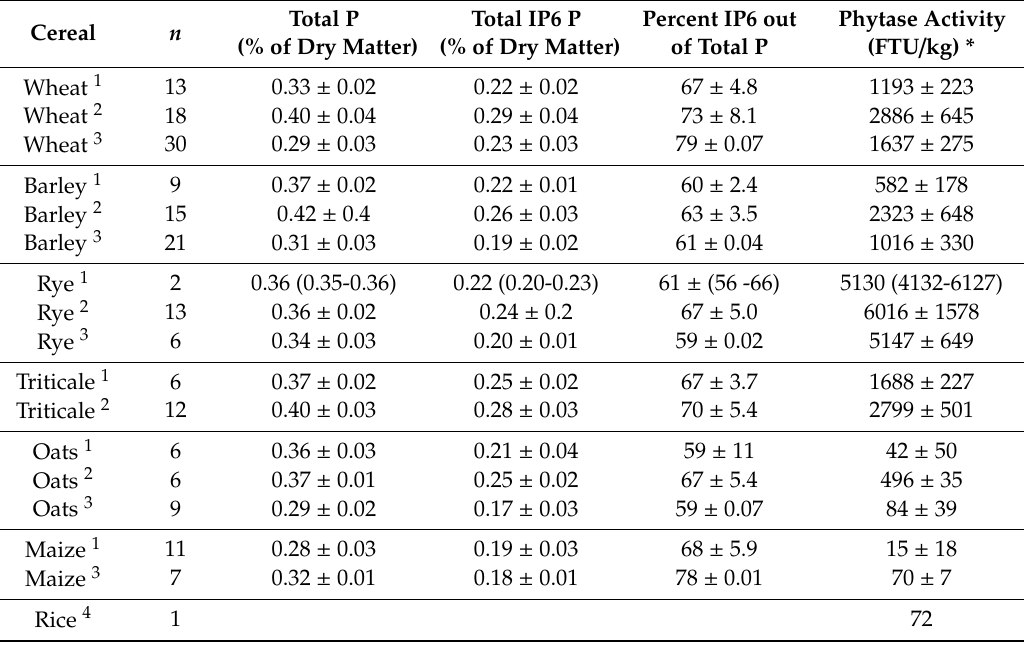
Table 1. Total P, IP6 bound P, proportion of IP6 bound P, and phytase activity in wheat, barley and other cereals seeds. The number of samples is n and ± denotes the standard deviation. The range is given if n ≥ 2. Data from [4] 1 , [5] 2 , [6] 3